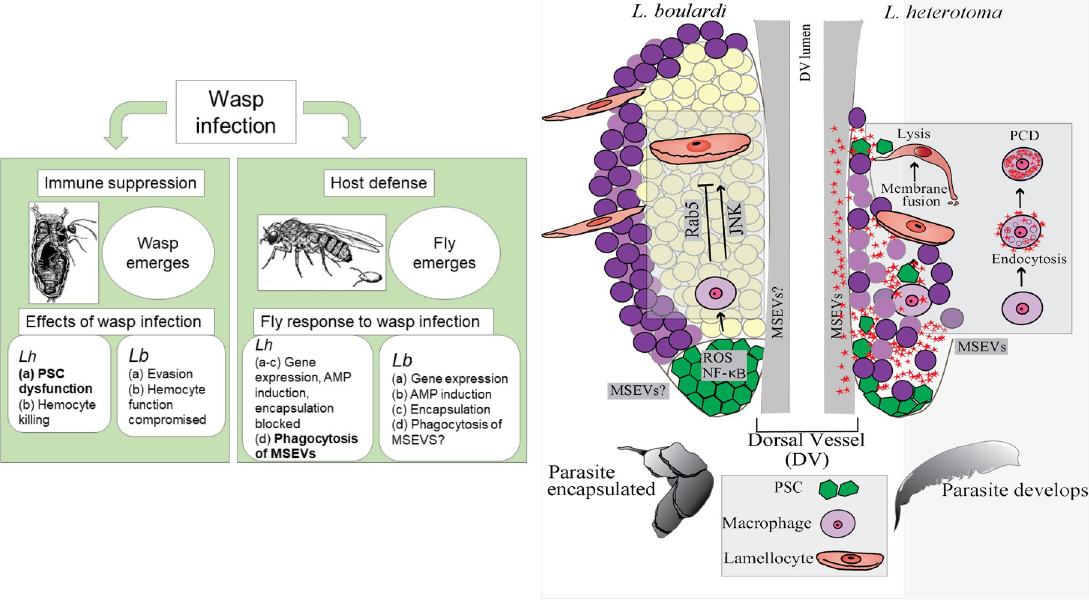
Fig 7. Lh EV interactions and effects on host blood cells: summary of events. Left: Immune suppression by Lh and Lb wasps and host defense in response to infection. Text in bold indicates findings from this study. Right: Lb attack triggers NF- κ B-dependent signaling events in the PSC and promotes lamellocyte differentiation of lymph gland progenitors (left lobe). This process is important in host defense against parasitic wasps [35,44] and is kept in check by Rab5. After Lh infection (right lobe), Lh MSEVs concentrate around and disassemble the PSC. They are phagocytosed by macrophages by a Rab5-dependent endocytic mechanism. In macrophages, EVs damage the phagolysosomal compartments. They are internalized by lamellocytes independently of Rab5 function. EVs lyse the few lamellocytes that differentiate post